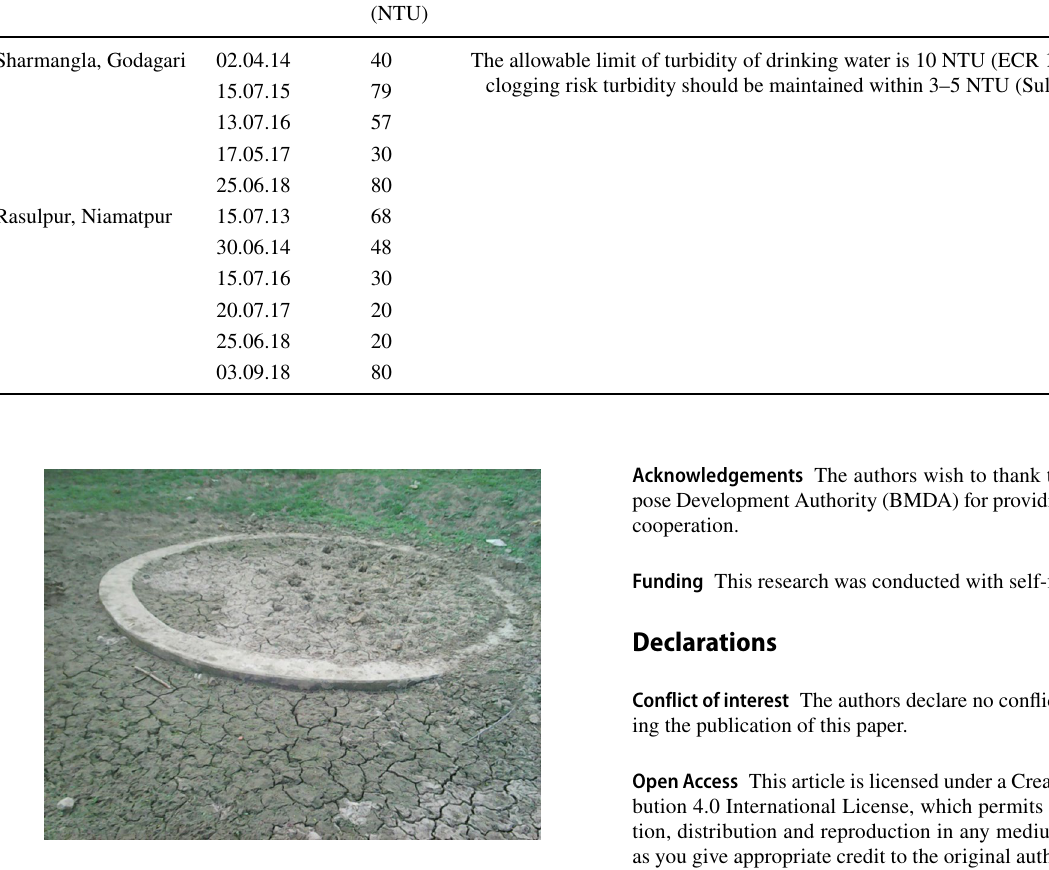
Fig. 13 Clogged RW along with silted Canal bed at